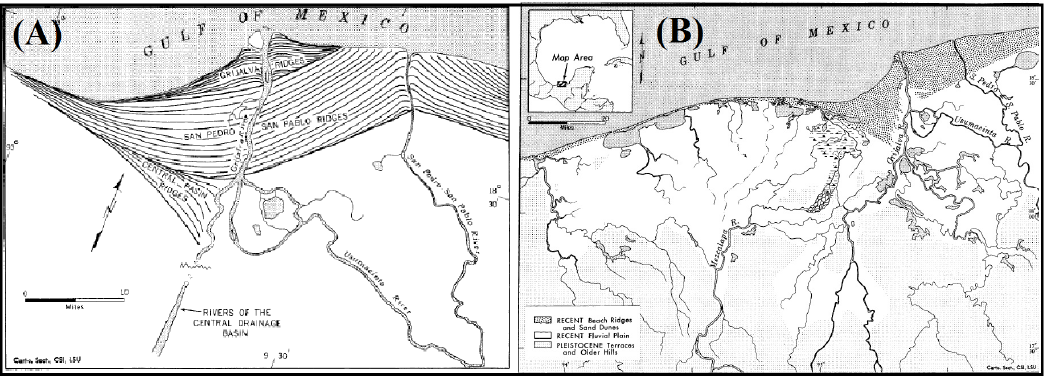
Figure 6. Beach ridges of Tabasco from Psuty [58] showing ( A ) the sequence of ridge construction and ( B ) anastomosing river systems that cause interior lagoon filling and delta building, used by permission.